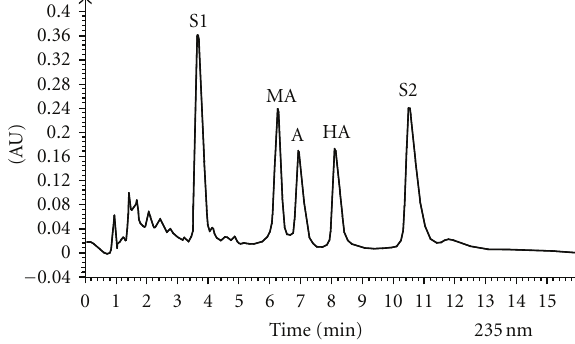
Figure 3: A chromatogram of A, MA, and HA obtained by automated analytical system (S1, S2 are internal